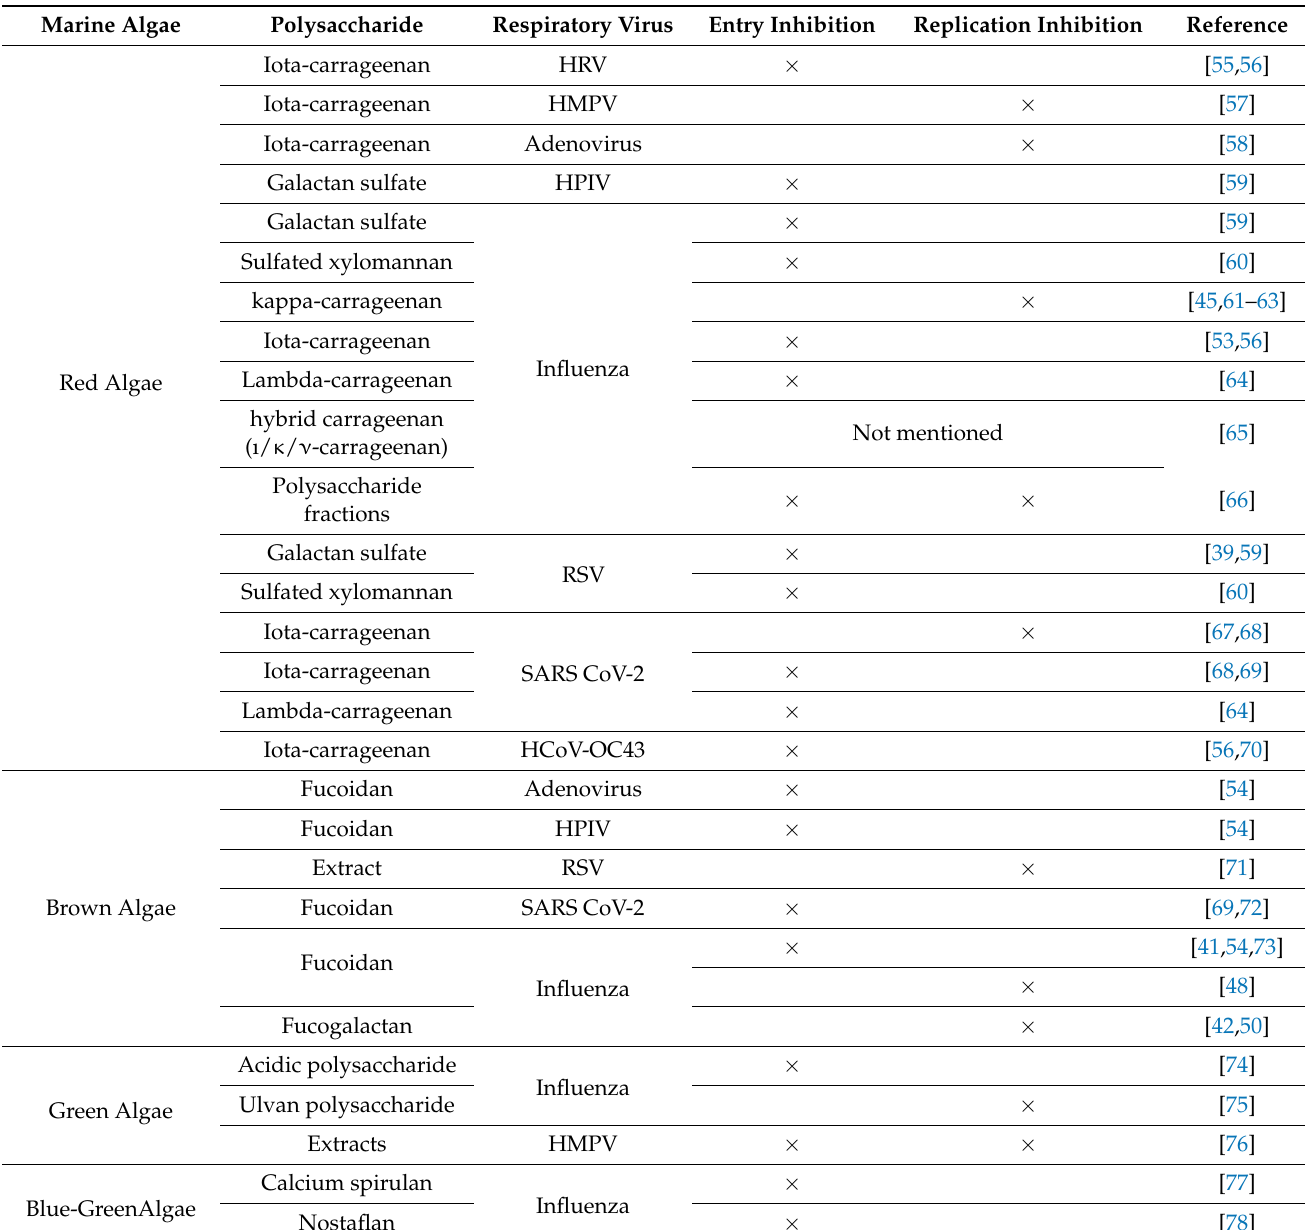
Table 2. Antiviral activity of seaweed sulfated polysaccharides against respiratory viruses based on their mechanism of action (entry or replication